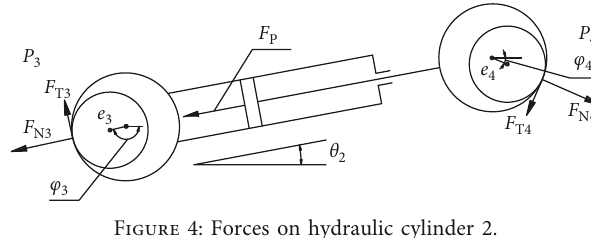
Figure 4: Forces on hydraulic cylinder